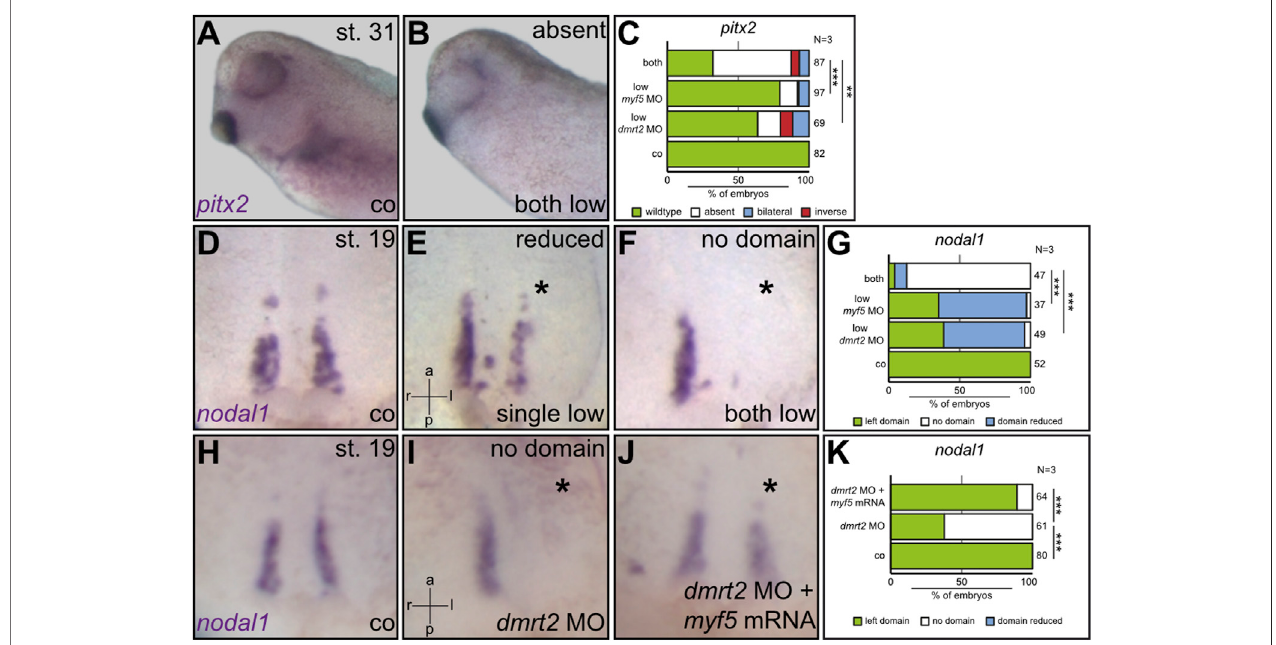
FIGURE 4 | Myf5 speci fi es sLRO cells downstream of Dmrt2. Using suboptimal dmrt2 MO and myf5 MO dosages, the cooperation of both transcription factors was demonstrated at the level of pitx2 asymmetry (A – D) and nodal1 expression in sLRO cells (D – G) . The combination of both MOs resulted in an ef fi cient loss of pitx2 and nodal1 expression. Note that individual MO injections had a weak impact on nodal1 in sLRO cells. Co-injecting myf5 mRNA rescued nodal1 expression in dmrt2 morphants (H – K) . Asterisks mark injected sides. Numbers in (C,G,K) represent analyzed specimens. N represents the number of independent experiments. Statistical analyses were done with one-sided Pearson ’ s chi-square test. ** highly signi fi cant p < 0.01; *** very highly signi fi cant p < 0.001. a = anterior; co = control; l = left; p = posterior; r = right.